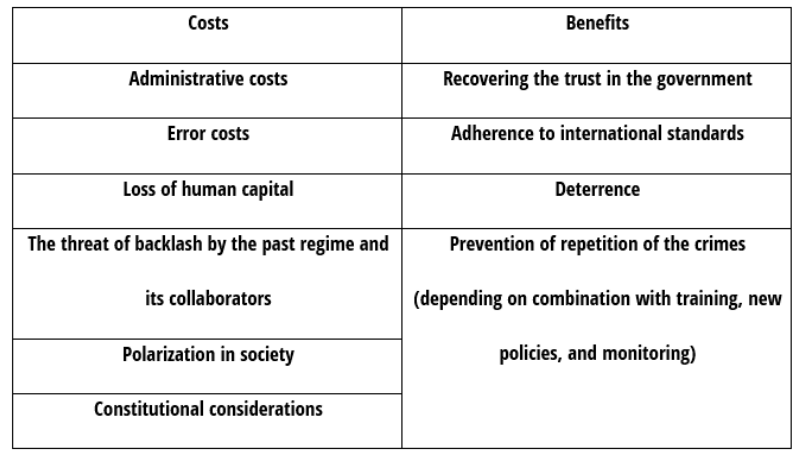
Figure 4: Table (4) Cost-Benefit Matrix of Lustration as a T.J.